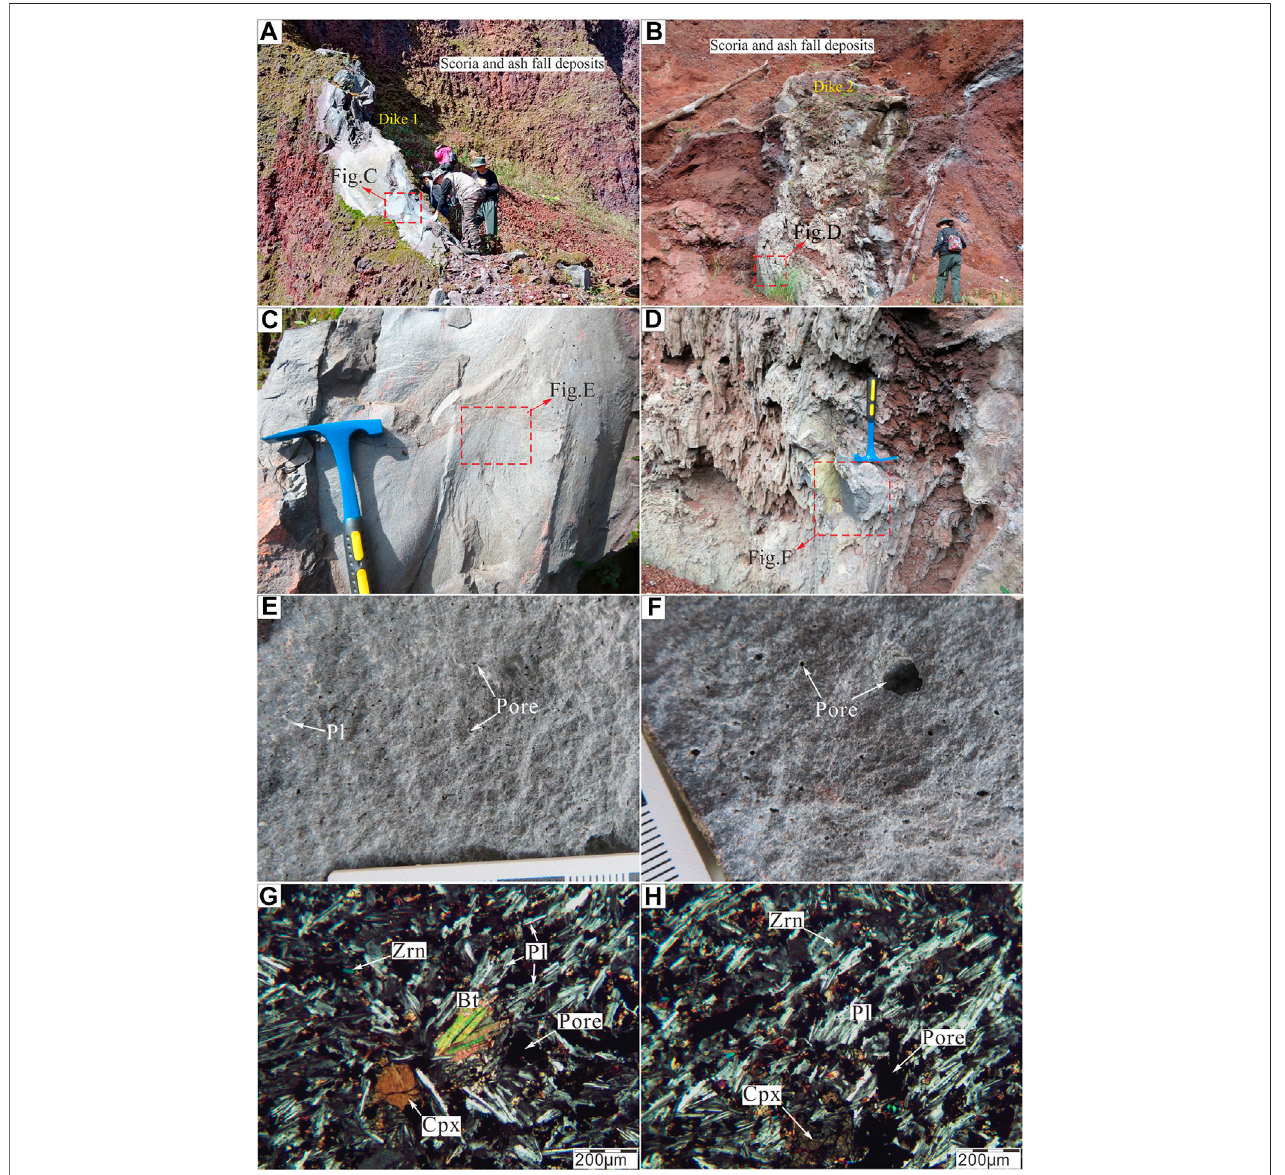
FIGURE 3 | Field photographs (A – D) , typical hand specimens (E, F), and photomicrographs (G, H) of the trachybasalt dikes in the study area. Abbreviations: Bt (cid:1) biotite; Cpx (cid:1) clinopyroxene; Pl (cid:1) plagioclase; Zrn (cid:1) zircon.